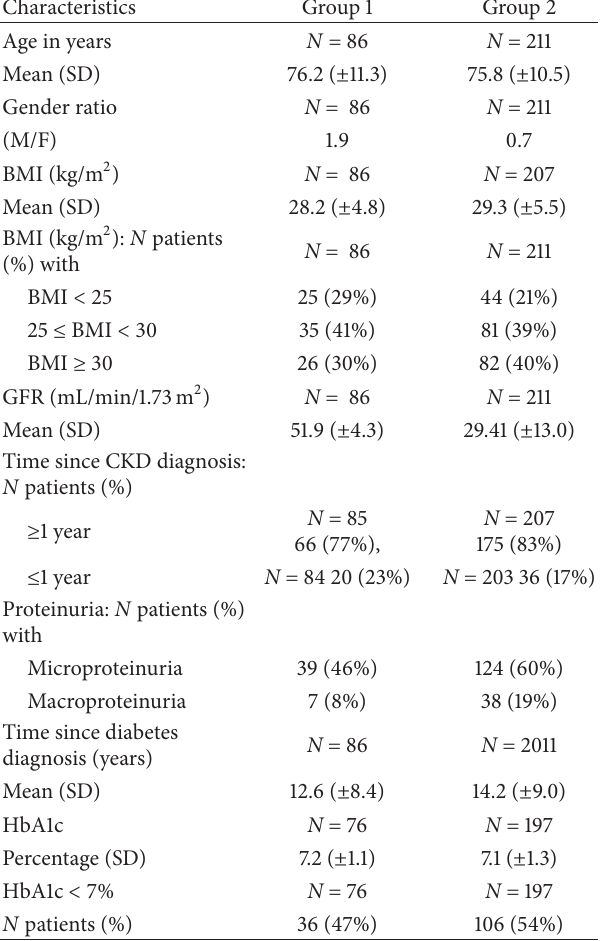
Table 1: Patient demographics and disease characteristics.